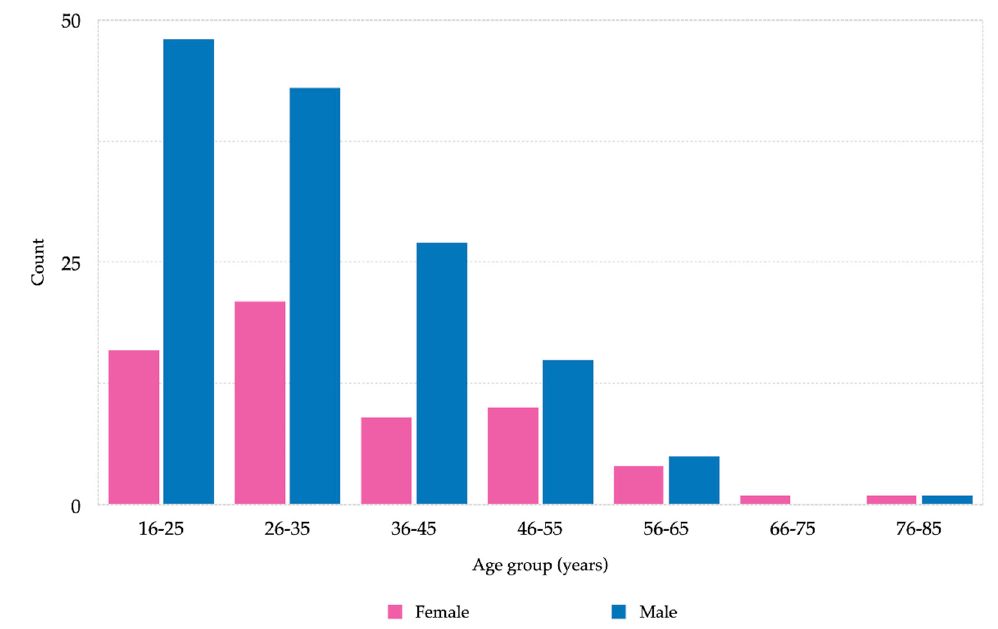
Figure 2. Total population by gender and age ( n = 201).